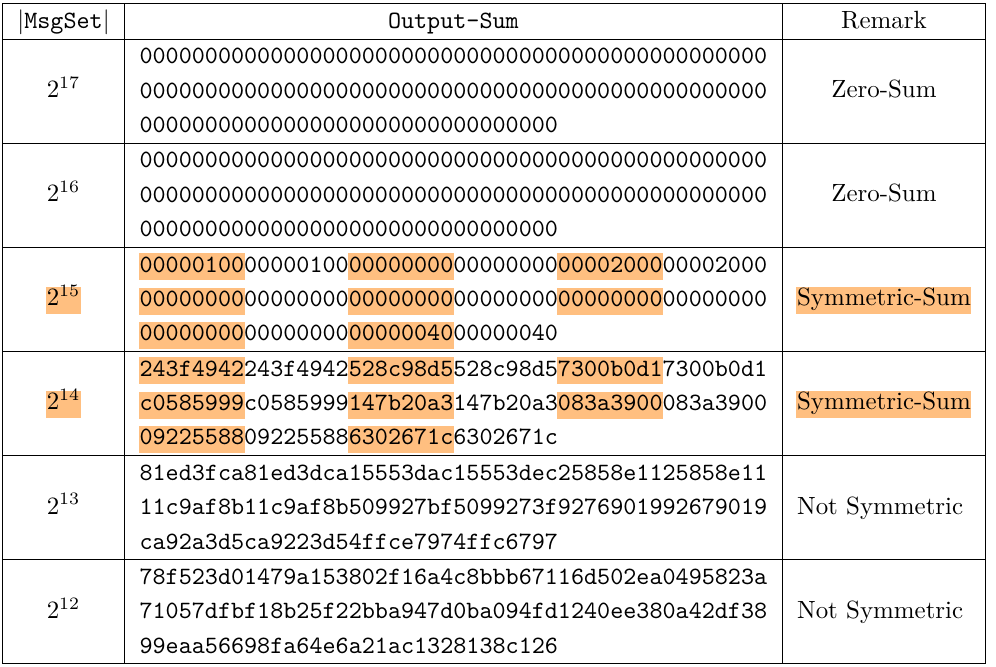
Table 2: Output-Sum exhibiting self-symmetric